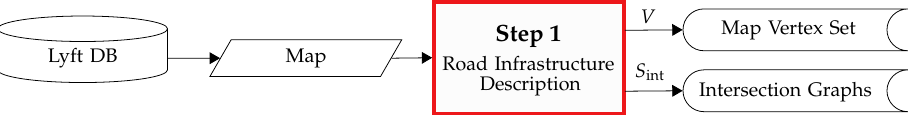
Figure 2. Overview of step 1 of the PROMOTING method: the road infrastructure description. A visual representation of the road infrastructure generated with information from the Lyft database is shown in Figure 3.